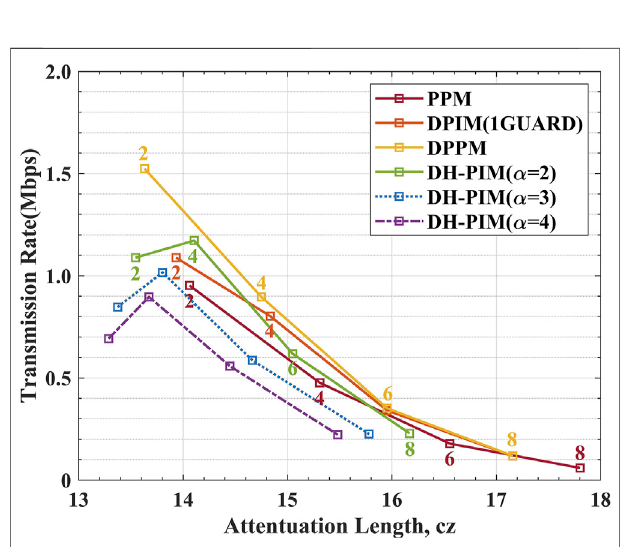
FIGURE4| Therateversustheattenuation lengthforBERis3 . 8 × 10 − 3 . The numbers marked on the curve indicate the values of M .